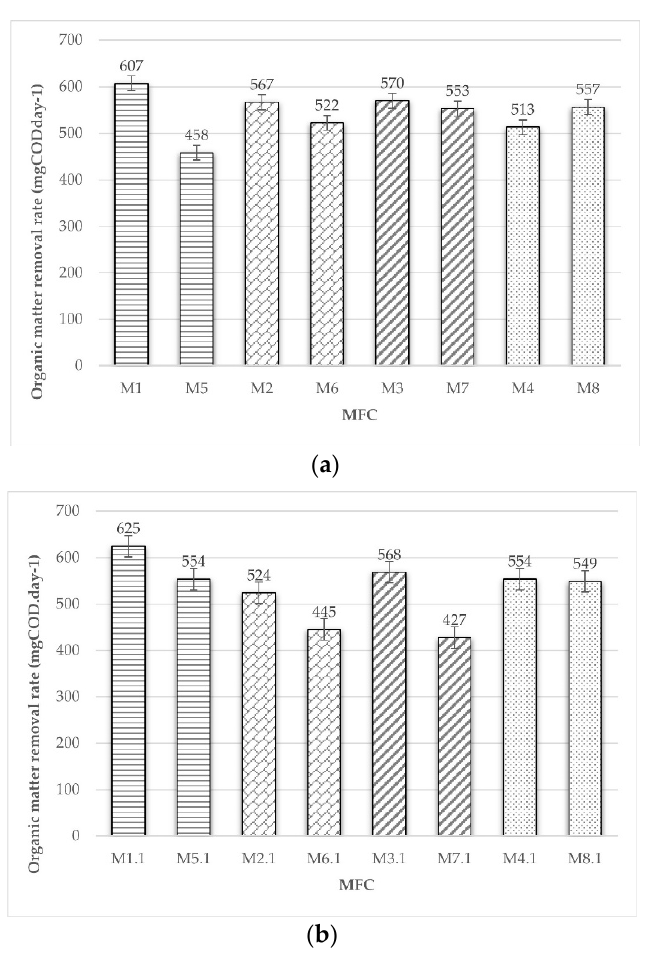
Figure 8. COD rate results for each experiment using the experimental design: ( a ) MFC in open-circuit operation; ( b ) MFC in closed-circuit operation.